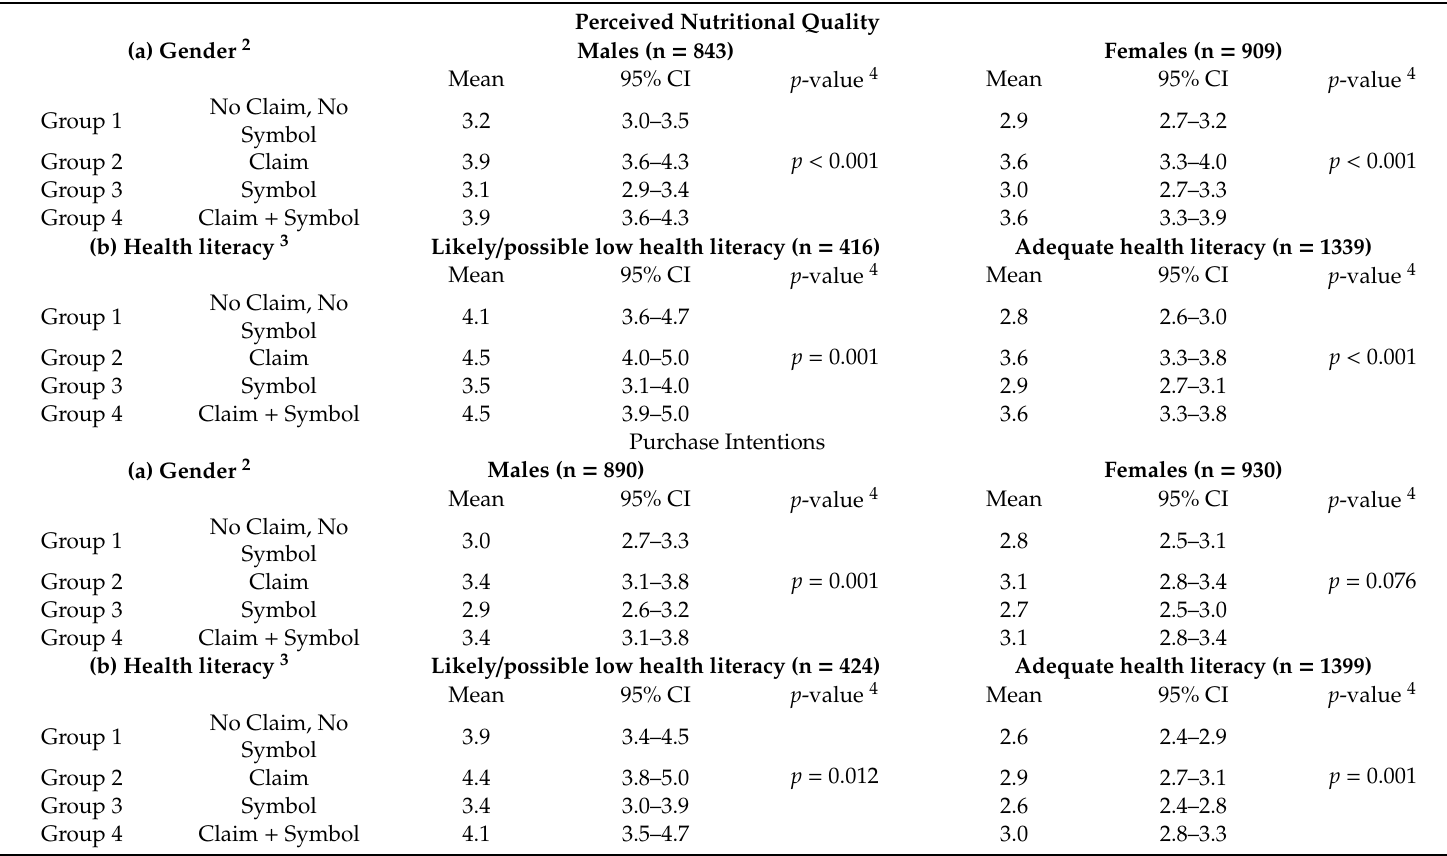
Table 3. Means ratings of perceived nutritional quality and purchase intentions by (a) gender and (b) health literacy (n = 1997) 1 . Perceived Nutritional